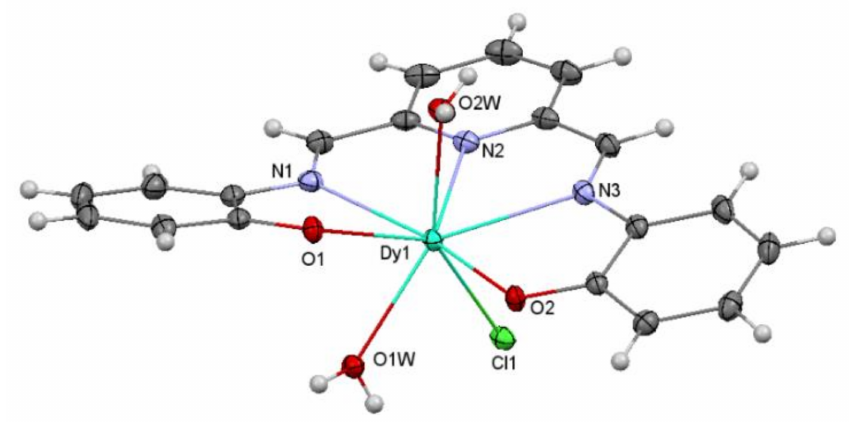
Figure 1. Ellipsoid diagram for 1 at 50%